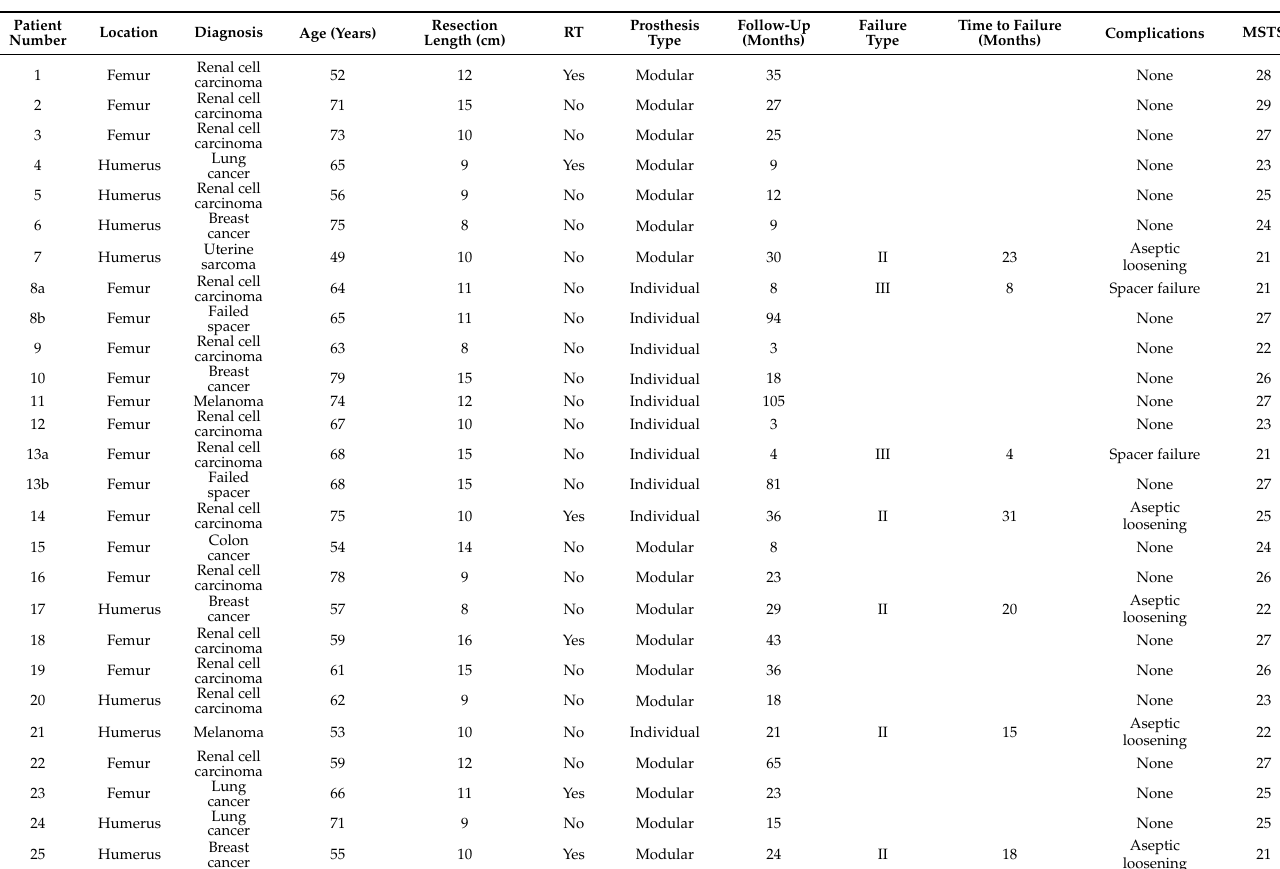
Table 1. Clinical dataset: patient details, complications, functional outcomes, tumor and endopros- theses characteristics.